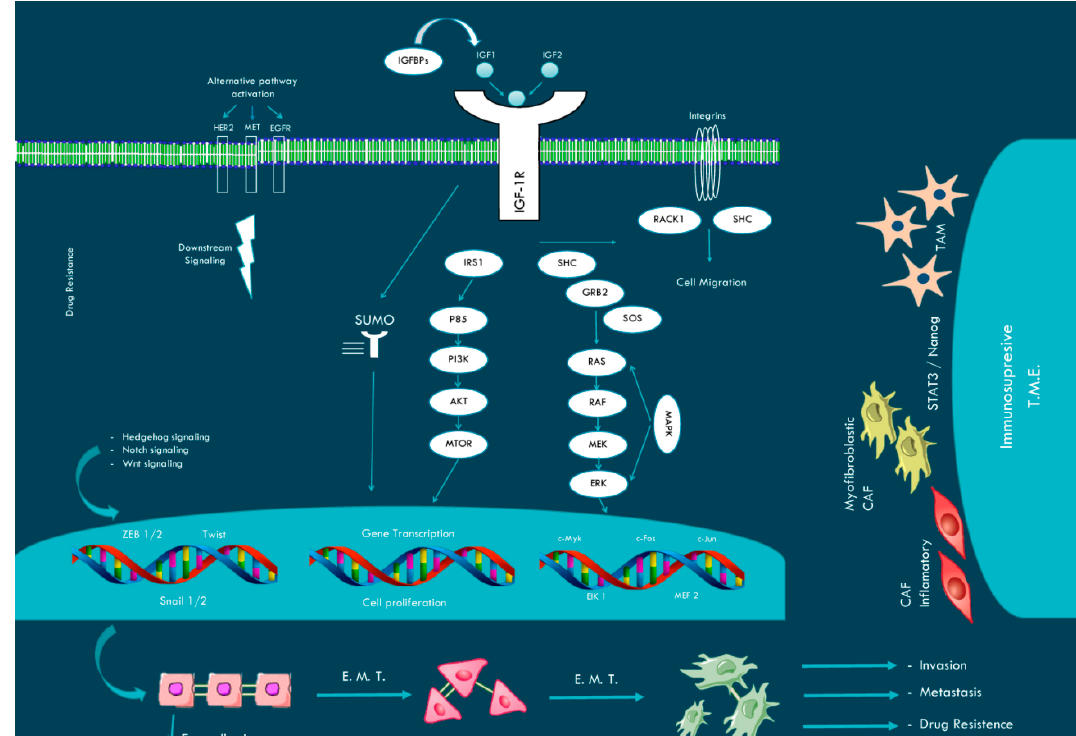
Figure 3. Schematic diagram of the IGF1R pathway. IGF1R phosphorylates the scaffold proteins IRS1 and can bind both PI3K (via the p85 subunit of PI3K) and the GRB2-SOS complex. PI3K activates downstream signaling (AKT, MTOR), whereas GRB-SOS stimulates RAS to activate the MAPK pathway (RAF/MEK/ERK). Both pathways can stimulate transcription factors such as c-Myc, c-Fos, and c-Jun to promote cell survival, proliferation, invasion, and metastasis. IGF1R crosstalks with integrins and RACK1 and FAK proteins and promotes cell migration. In addition, IGF1R SUMOylation and EMT can also contribute to proliferation and apoptotic resistance. Interaction with other RTKs such as HER2, MET, and EGFR constitutes an alternative IGF1R pathway. Finally, IGF1R signaling can also promote an immunosuppressive tumor microenvironment.